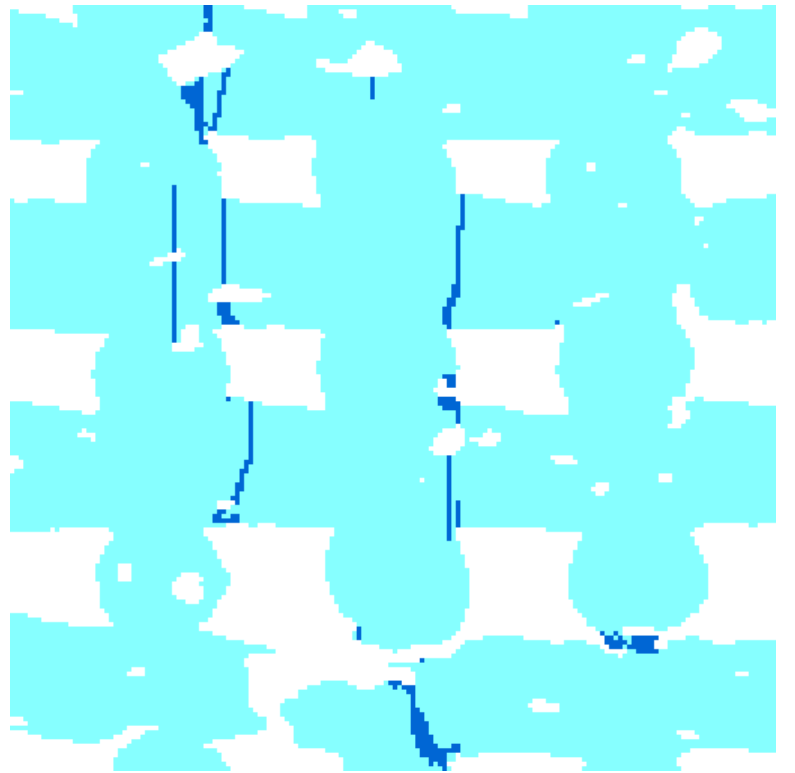
Figure 6. Section of the scaffold in the xz-plane, under compressive load along the z-direction (vertical). Cracks are highlighted in dark